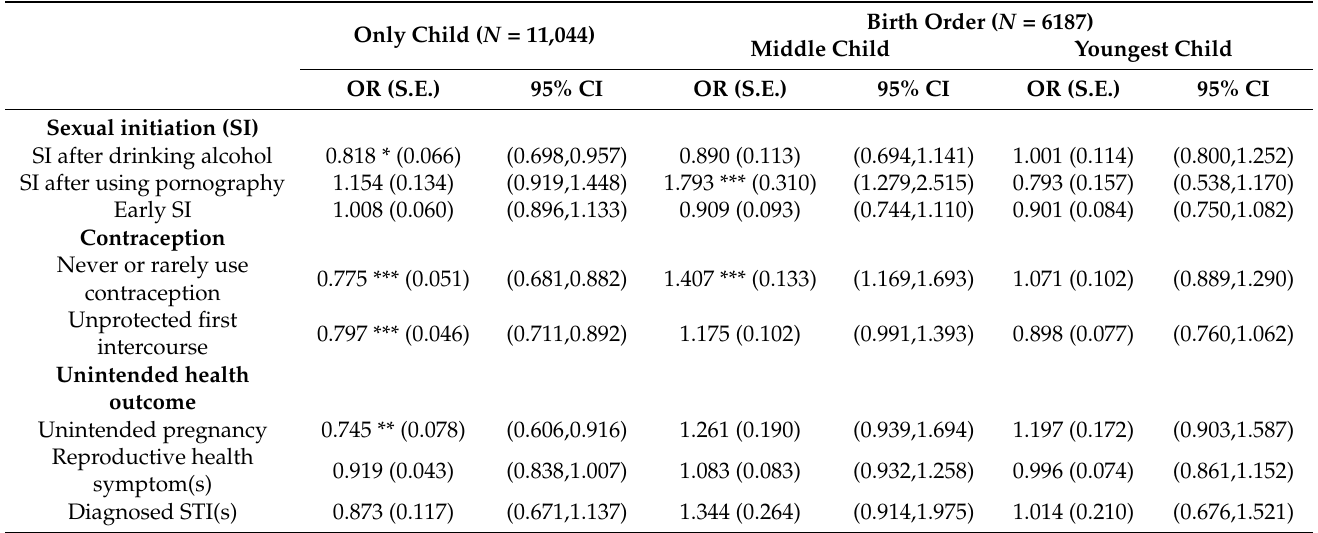
Table 3. Logistic regression of one child or birth order for sexual and reproductive health among Chinese young